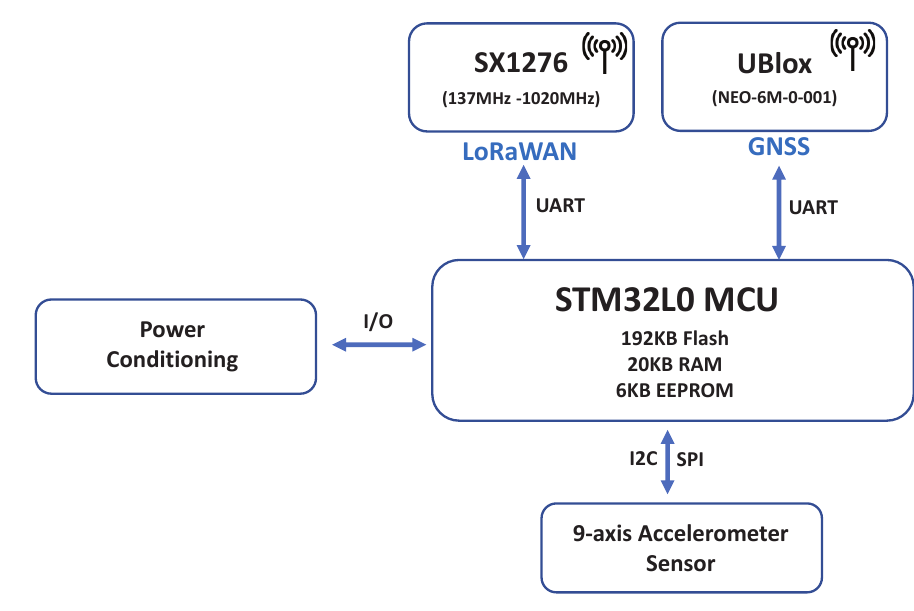
Figure 3. Hardware block